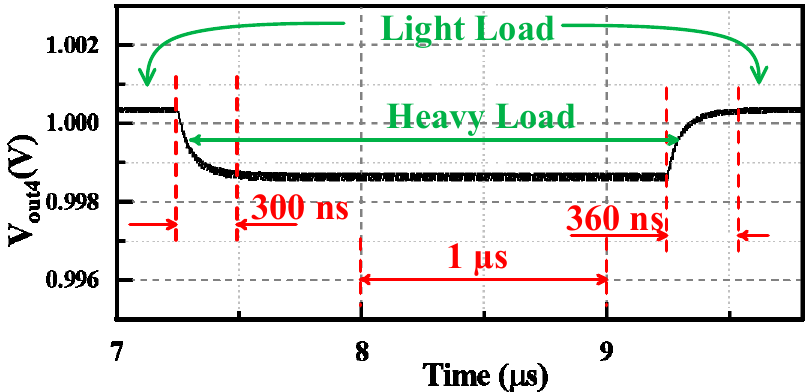
Figure 20. The post-layout simulation results of the load transient performance of the proposed SSC-DVS architecture.